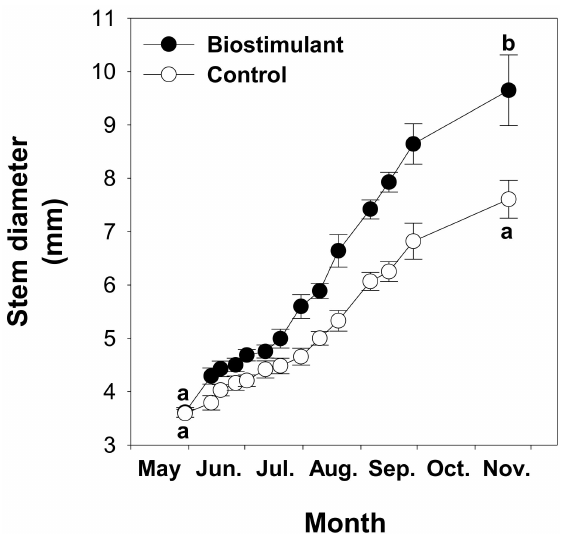
Figure 1. Diametral growth of the stem of treated and control potted trees during the vegetative season of 2018. Bars represent standard errors. At the beginning and at the end of the experiment, means accompanied by di ff erent letter are significantly di ff erent at p <